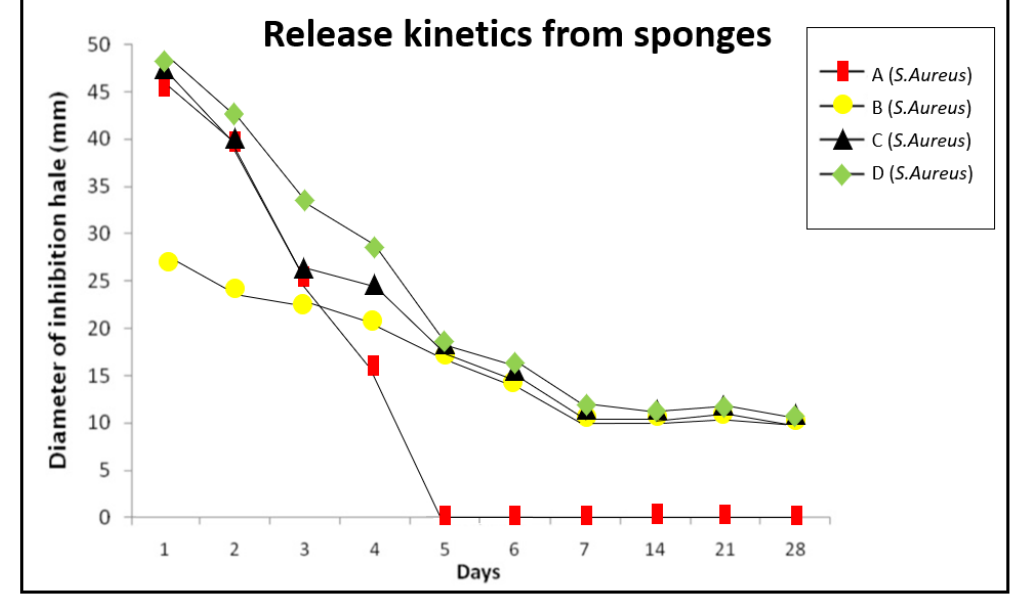
Figure 4. Release kinetics from sponges. Inhibition halos obtained on days against S. aureus ; square: sponge A; circle: sponge B; triangle: sponge C; rhombus: sponge D.